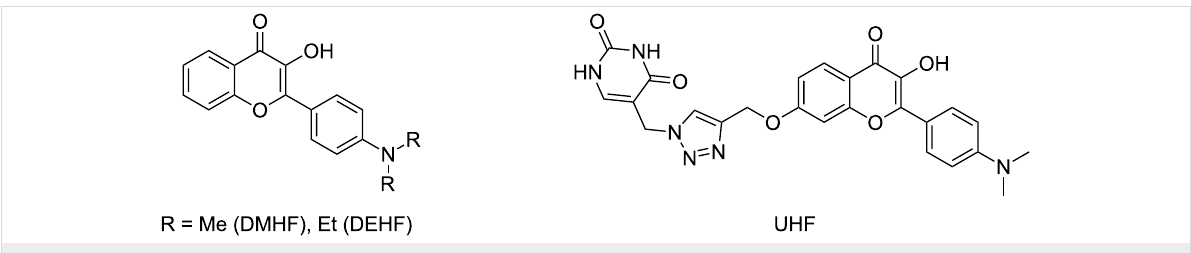
Figure 1: Structures of the studied hydroxyflavone